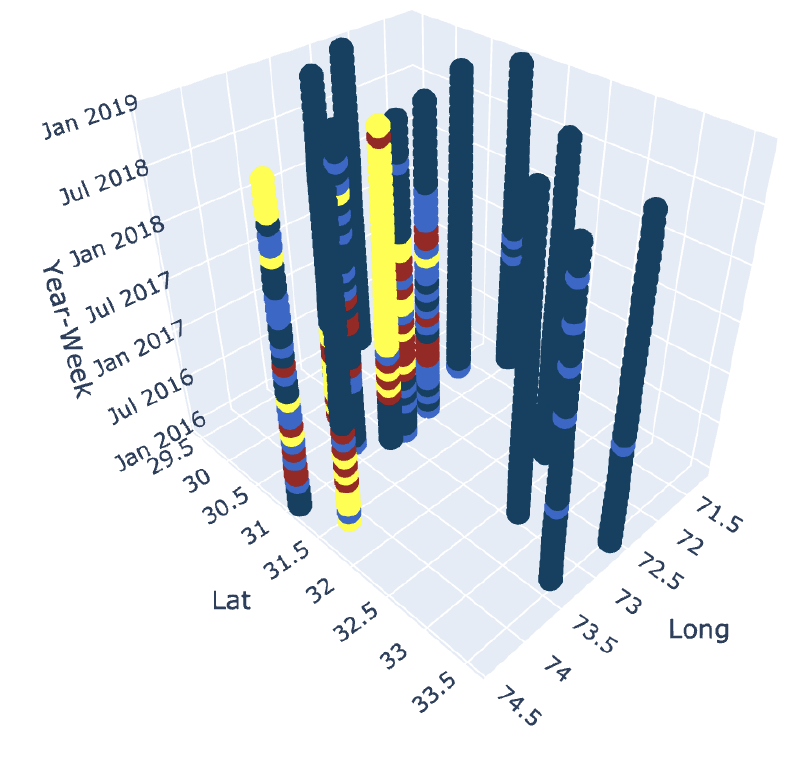
Figure 6. Hotspot trend in an interactive 3D plot over 180